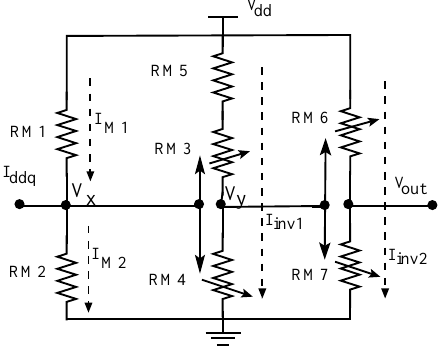
Figure 11. Resistor equivalent model of the proposed